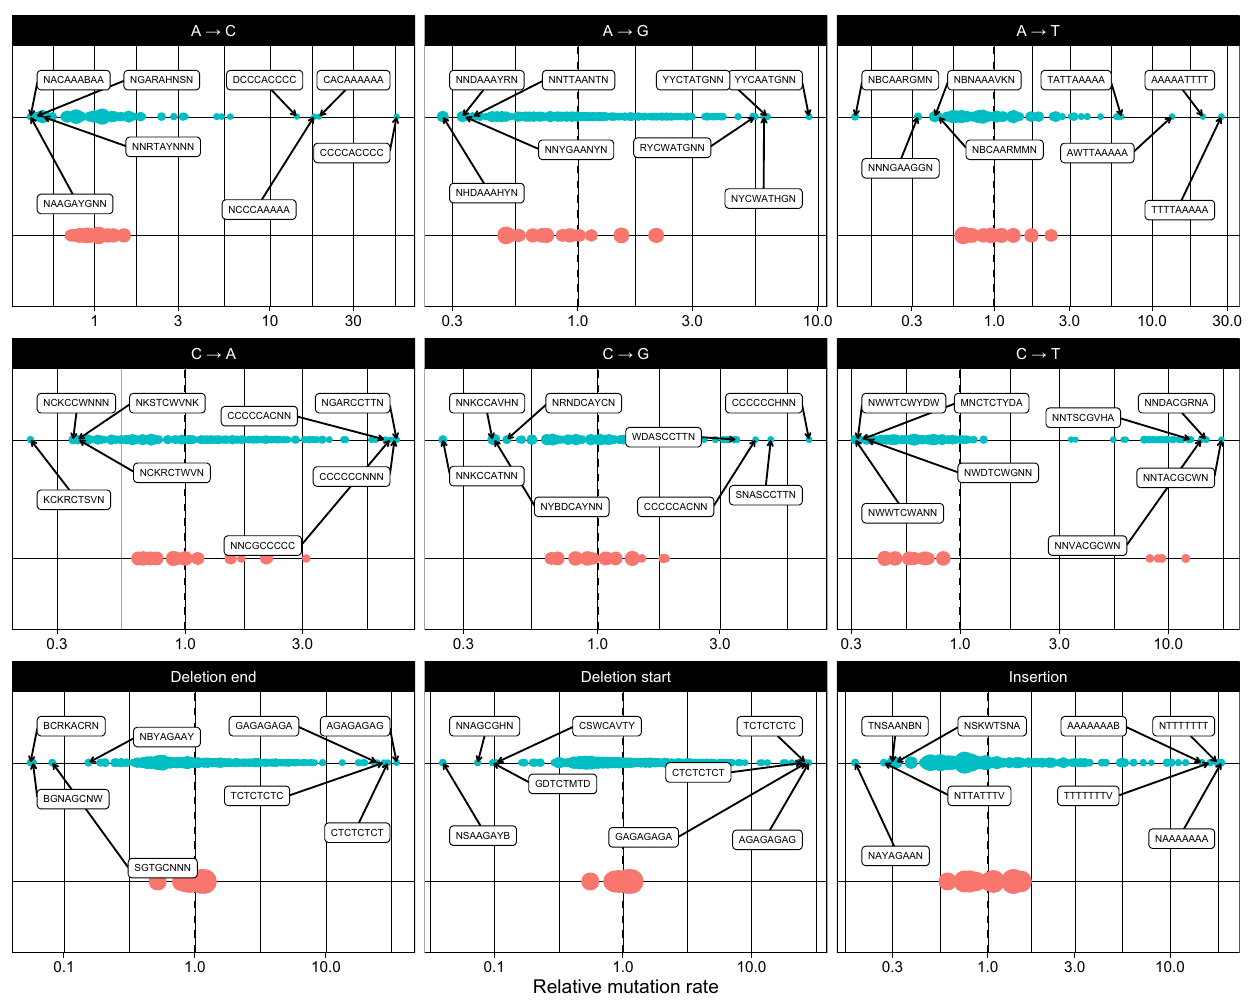
Fig. 4 | The relative mutation rate for each of the patterns in the kmerPaPa models. The blue points show the rate for the kmerPaPa patterns, the red points show the rate for each 3-mer. The dashed vertical line corresponds to the average